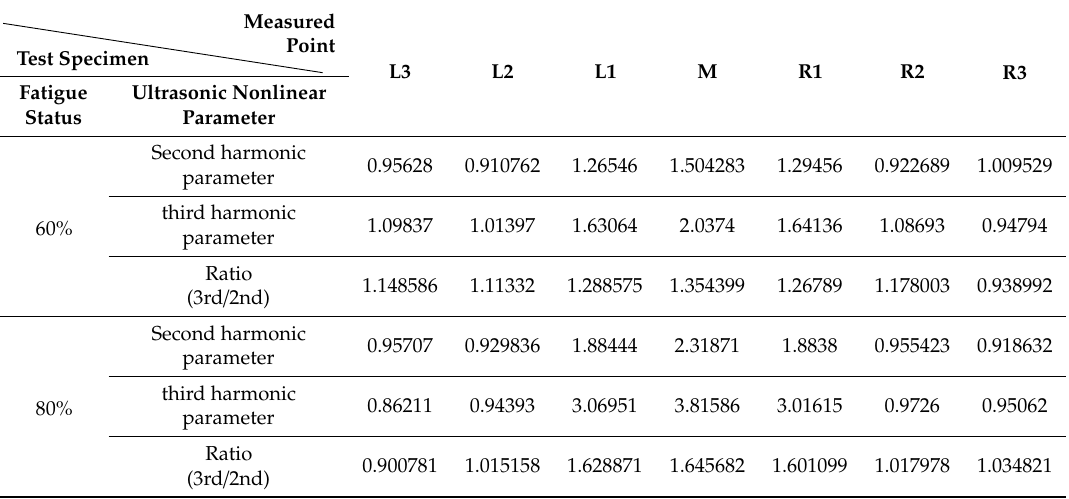
Table 4. Comparison on second and third harmonic nonlinear